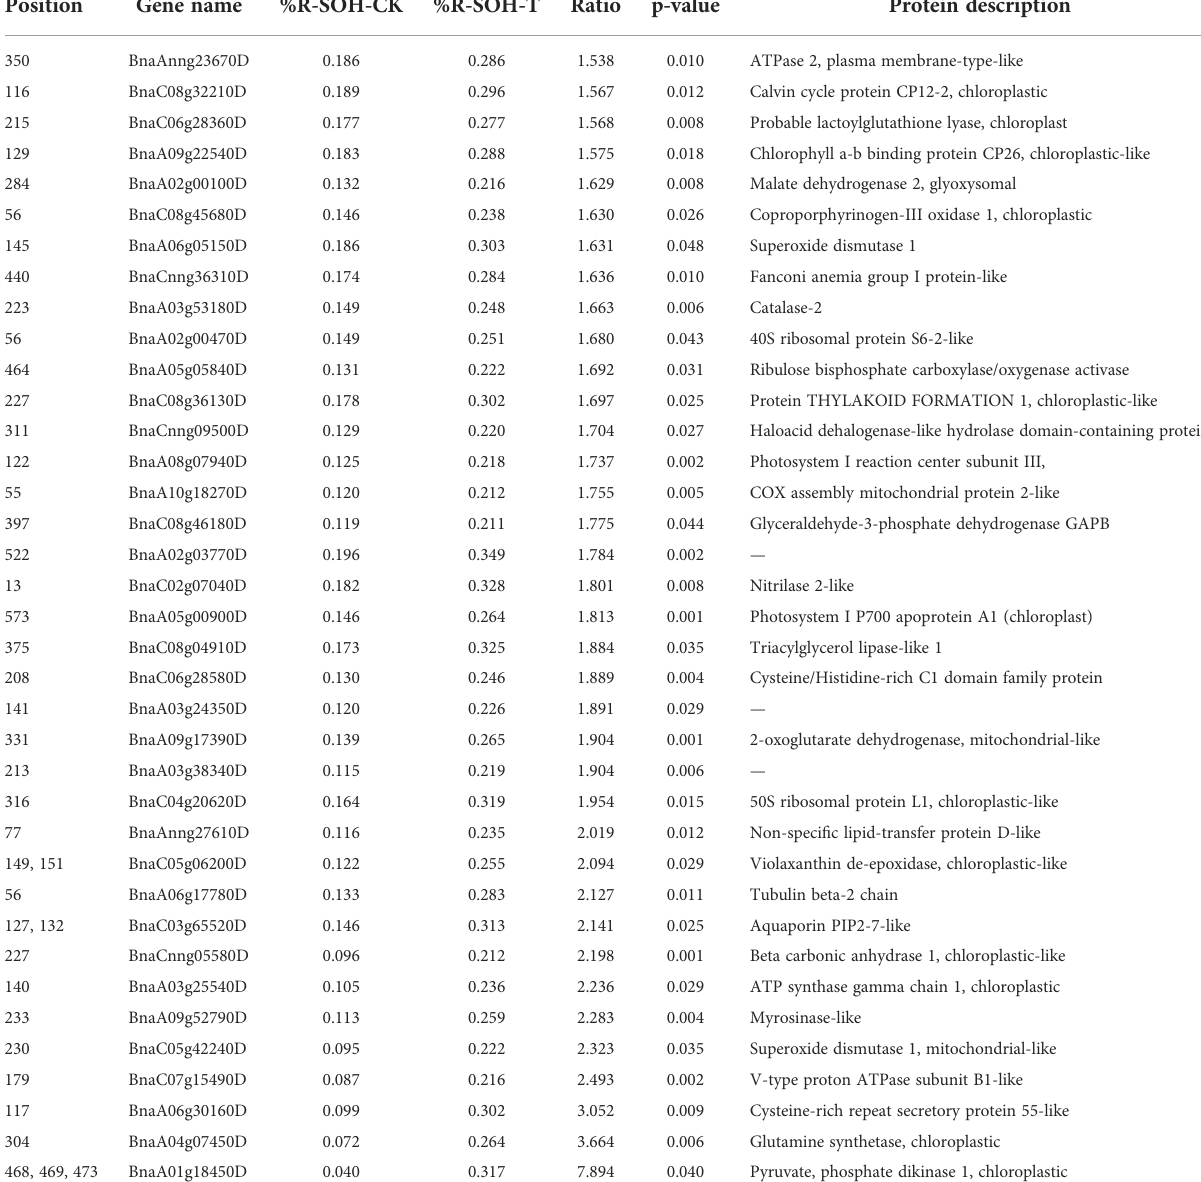
TABLE 1 Differentially sulfenylated sites and proteins changed from low to high sulfenylation level .